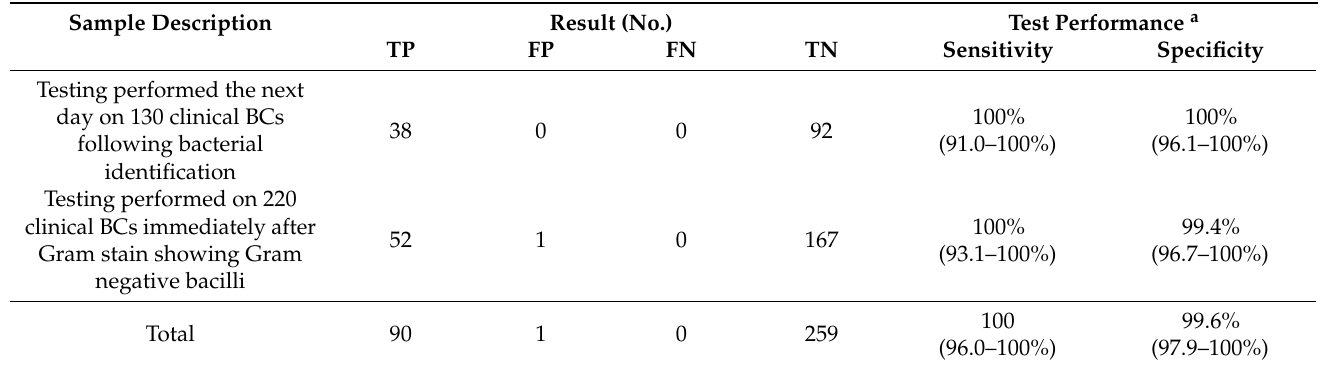
Table 3. Summary of test results from clinical blood